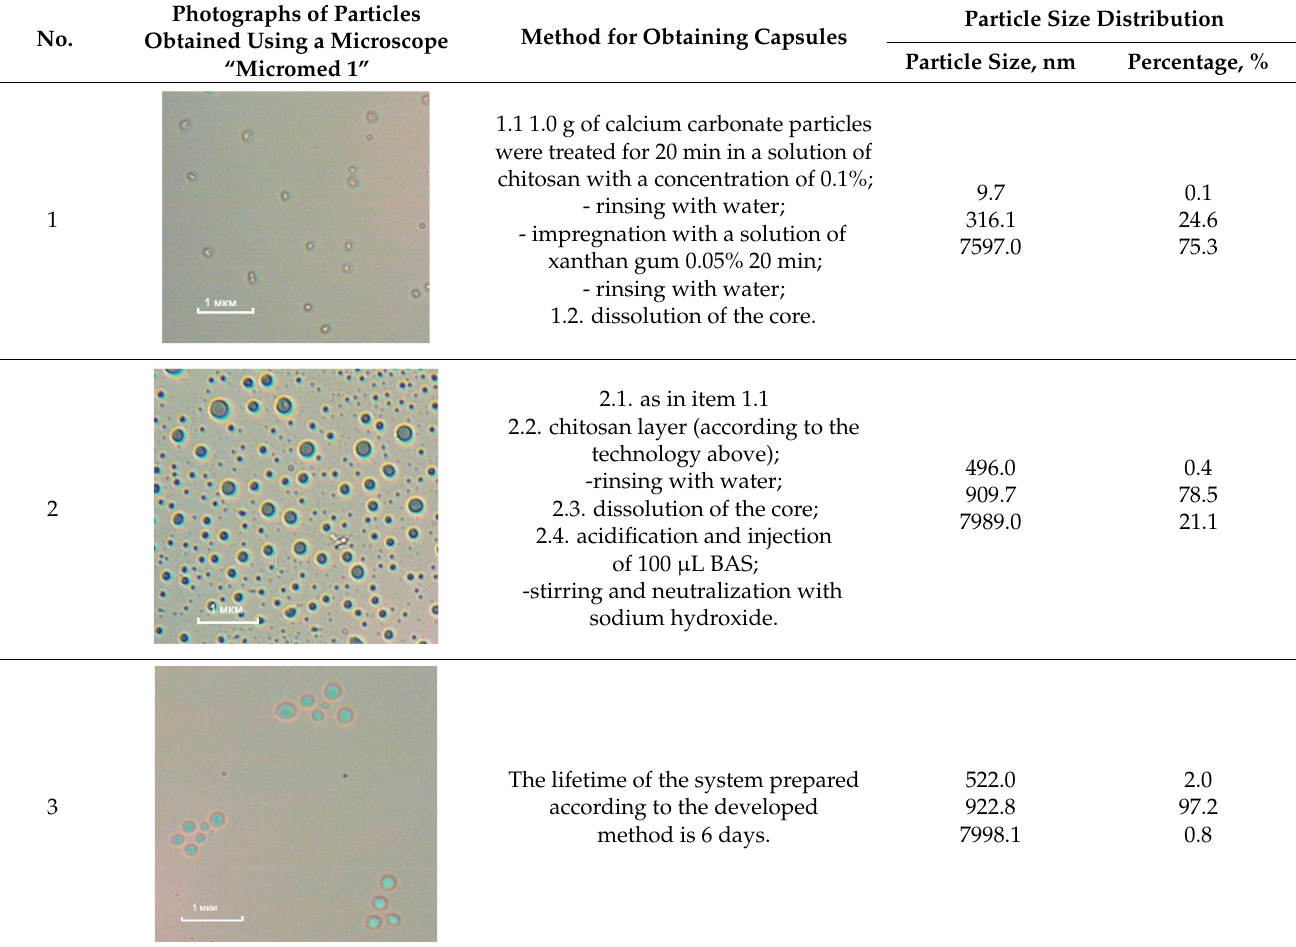
Table 2. Influence of the capsule formation technique on their appearance and aggregate stability.